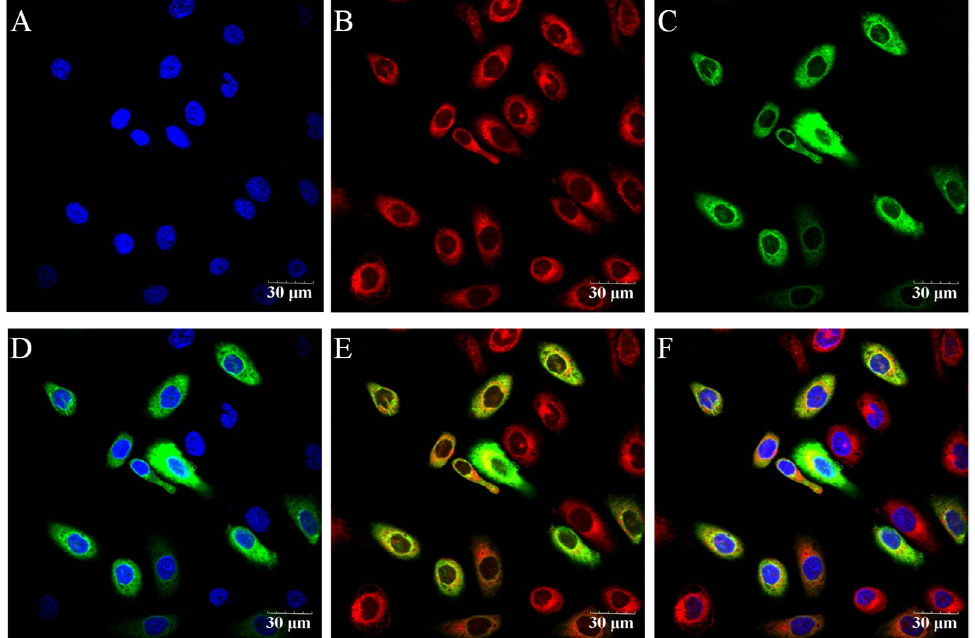
Figure 2. Immunofluorescent staining of nucleus (blue), mitochondria (red) or EGFP- SOCS1 (green) and confocal microscopy analysis in BuMECs. ( A , B ) Nucleus and mitochondria stained with Hoechst 33342 and Mito-Tracker, respectively; ( C ) green fluorescent protein was expressed by EGFP- SOCS1 ; ( D ) merged overlaid nucleus and EGFP- SOCS1 ; ( E ) merged overlaid mitochondria and EGFP- SOCS1 ; ( F ) merged overlaid nucleus, mitochondria and EGFP- SOCS1 .